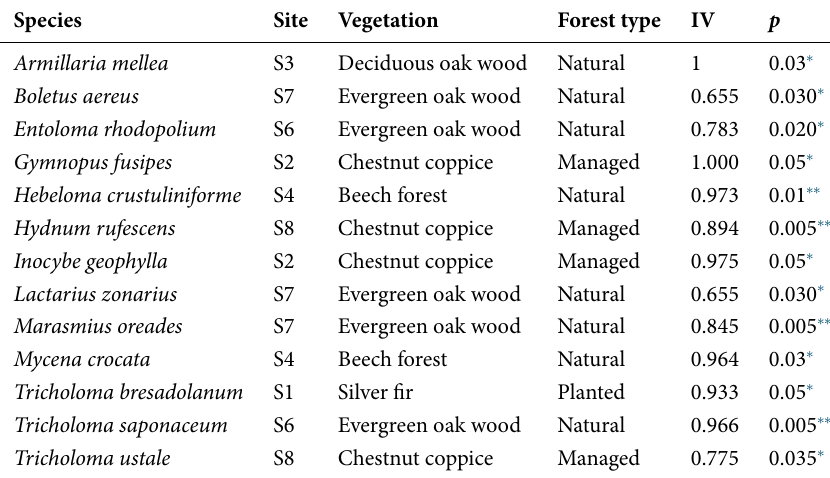
Table 3 Summary of indicator species